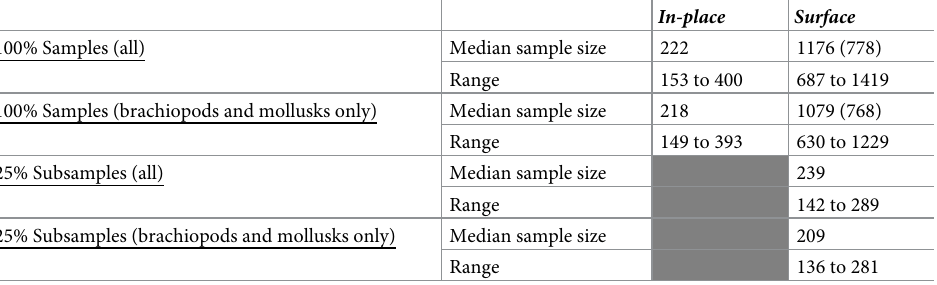
Table 1. Sample size comparisons between in-place and surface-collected samples. Numbers in parentheses are the median sample sizes of the collector who collected from all seven surfaces. Subsampling was only necessary for surface samples, so there are no subsampling results listed for in-place samples.